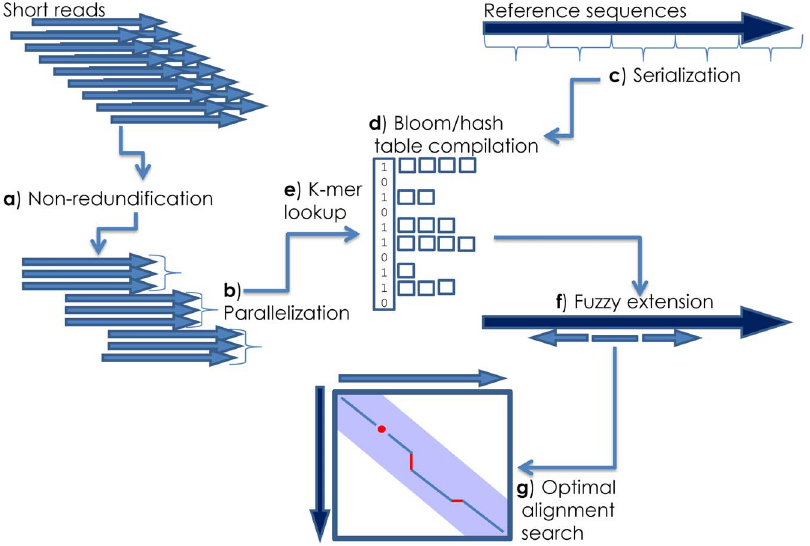
Figure 1. Workflow for HIVE-hexagon alignment utility. Overall alignment schema for HIVE-hexagon: short reads are non-redundified ( a ) and parallel portions ( b ) are sent to distributed cloud for computation. Reference genomes are then split into smaller pieces ( c ) and compiled into bloom/ hash table ( d ). Every parallel execution thread performs a K-mer lookup against every reference sequence ( e ) then extends matches via inexact alignments ( f ) and performs a subsequent optimal alignment search on remaining candidates ( g ).